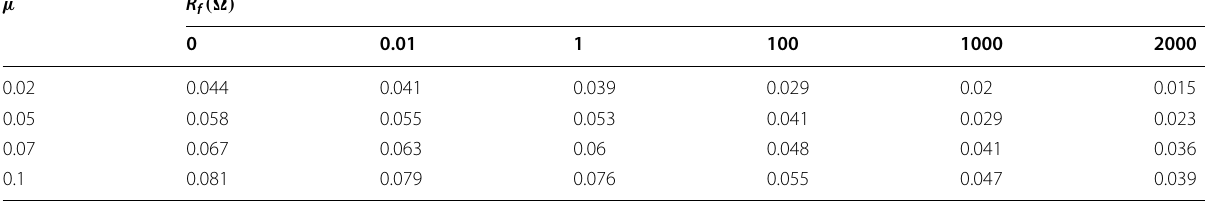
Table 4 Average current criterion value for different fault resistance